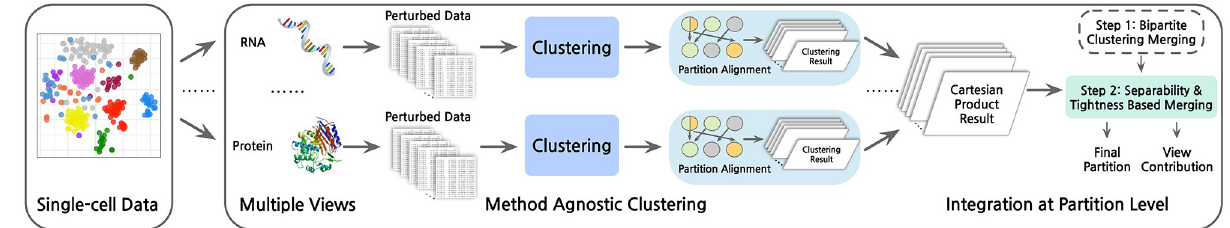
Fig 1. The pipeline of CPS-merge analysis. When there are more than two views, users can either directly treat the Cartesian product clusters with higher orders or conduct step-wise merging such that two views are treated at each step. Current mutlimodal single-cell datasets only contain two